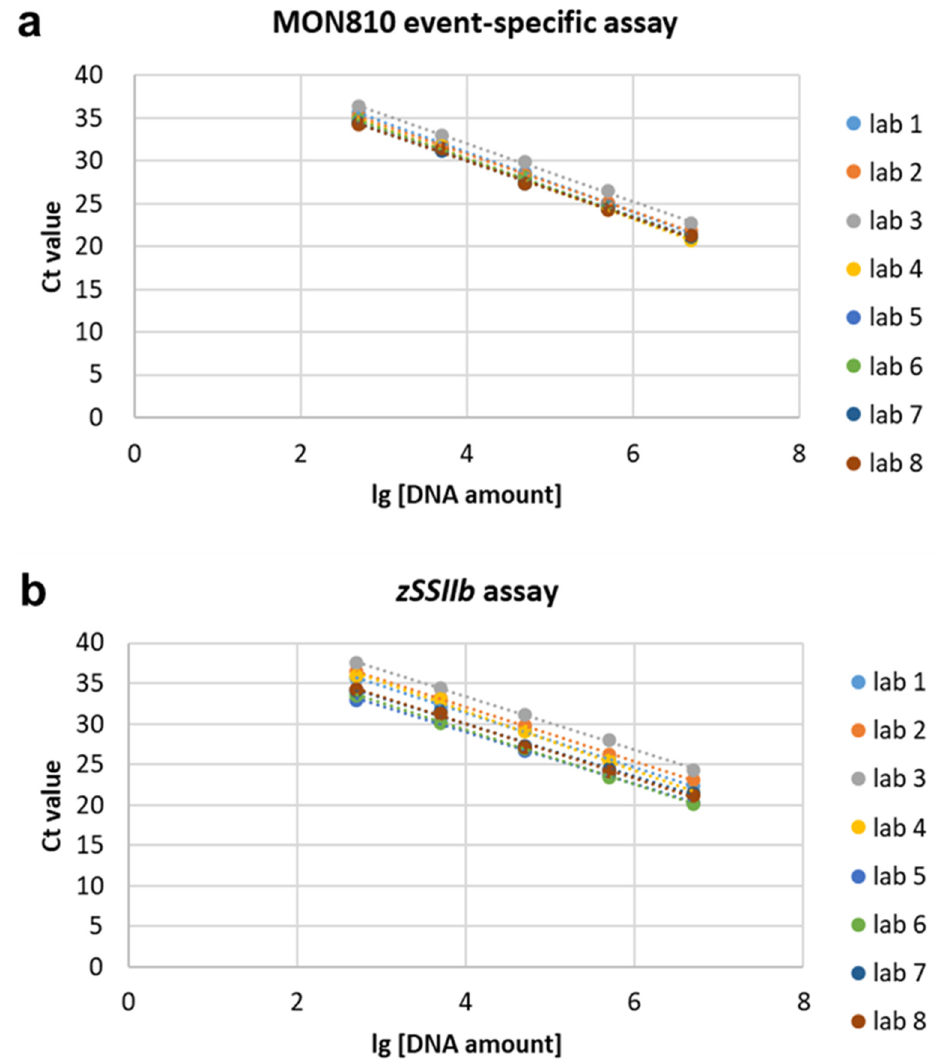
Figure 2. Constructed standard curves from qPCR assays employing pMON810 plasmid DNA dilutions as calibrators from eight participants. ( a ) The standard curves of MON810 assay. ( b ) The standard curves of zSSIIb assay.